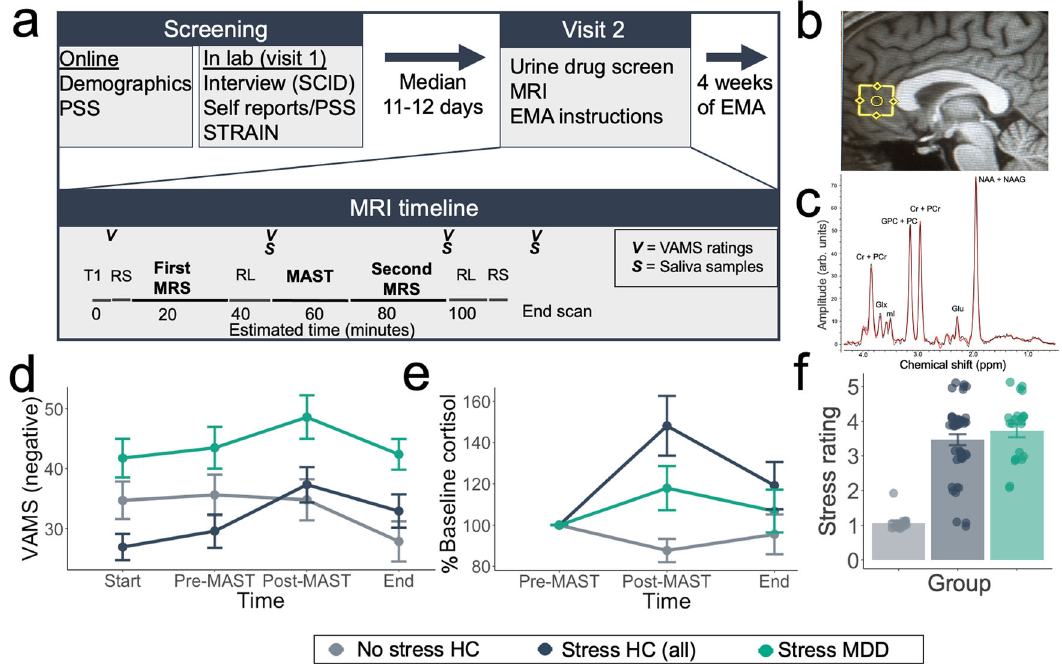
Fig. 1 Study design and effects of stress on salivary cortisol and subjective ratings. a Schematic diagram of the study visits and approximate timing of MRS, fMRI RL task, VAMS, and saliva measurements. Note that the Healthy Control Stress sample did not complete resting-state scans, STRAIN, or EMA. EMA Ecological Momentary Assessment, MRS Magnetic Resonance Spectroscopy, PSS Perceived Stress Scale, RL Reinforcement Learning, RS Resting State, SCID Structured Clinical Interview for DSM Disorders, STRAIN Stress and Adversity Inventory. MAST Maastricht Acute Stress Test, VAMS Visual Analog Mood Scales. b Representative MRS voxel placement. c Representative MRS spectrum (black) and LCModel fi t (red) with labeled metabolite peaks. arb.units arbitrary units, Cr creatine, PCr Phosphocreatine, Glu glutamate, Glx (glutamine + glutamate), GCP glycerophosphocholine and PC, phosphocholine (choline-containing metabolites), ml myo-inositol, MRS Magnetic Resonance Spectroscopy, NAA N-acetylaspartic acid, NAAG N-acetylaspartylglutamate, ppm parts per million. d Effect of MAST acute stress task and No Stress Control (NSC) on mood. Items are coded such that higher scores indicate greater negative emotional experience and averaged across items. Data represented as mean ±standard error of the mean ( N = 75 participants). e Salivary cortisol response to acute stress manipulation and no-stress control. Graph depicts percent change in salivary cortisol from the timepoint immediately prior to the onset of the MAST stressor (Pre-MAST). Data represented as mean ±standard error of the mean ( N = 83 participants). f Subjective stress ratings for each group (1 – 5). Data represented as mean ± standard error of the mean ( N = 82 participants). HC Healthy Control participants, MDD participants with Major Depressive Disorder. Source data for d – f are provided as a Source Data fi